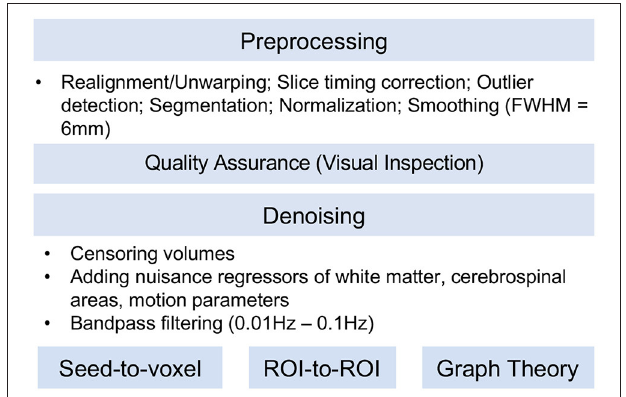
FIGURE 4 | Pre-processing pipeline for resting-state fMRI. Data will be preprocessed with the sequence of realignment/unwarping, slice timing correction, head movement outlier detection, segmentation, normalization, and smoothing with 6mm of Full width at half maximum (FWHM). Each subject’s images will be visually inspected for quality control. Denoising will be performed by volume censoring with the conservative criteria (i.e., the threshold of a global-signal z-value of 3 or 0.5mm volume-to-volume motion), adding nuisance regressors of white matter, cerebrospinal areas, and motion parameters, and bandpass filtering to a 0.01–0.1Hz window. For the statistical analysis, seed-to-voxel, ROI-to-ROI, and graph theory analysis will be implemented. FWHM, Full width at half maximum; ROI, Region of